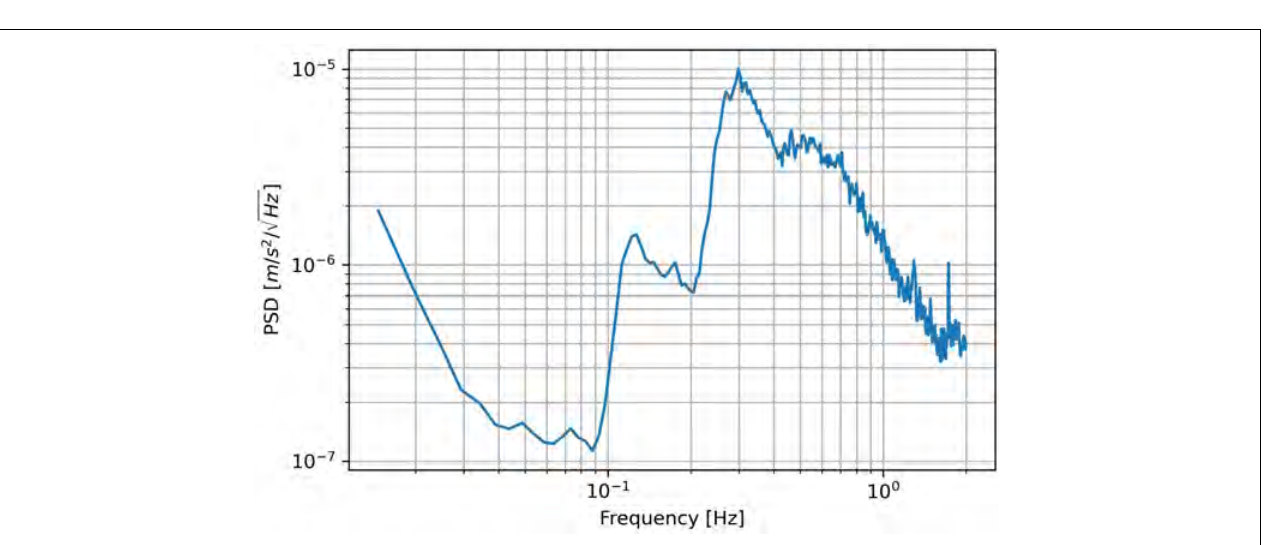
FIGURE 6 | Power spectral density (PSD) of the micro-seismic signal recorded on the February 5, 2014 at 23:00. The corresponding sea waves parameters from the buoy were: